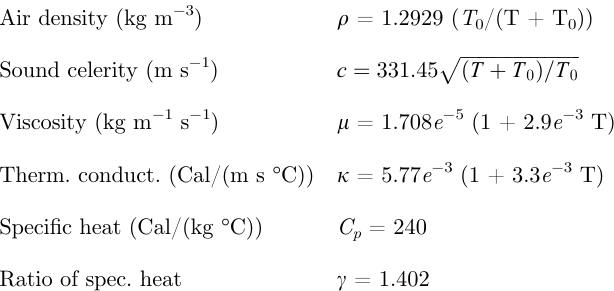
Table 2. Physical constant values ([22], chap. 5.5.2, p. 241). T is the temperature in Celsius and T 0 = 273.15 K. In this study T = 20 (cid:3) C. Air density (kg m (cid:3) 3 ) q = 1.2929 ( T 0 /(T + T 0 ))